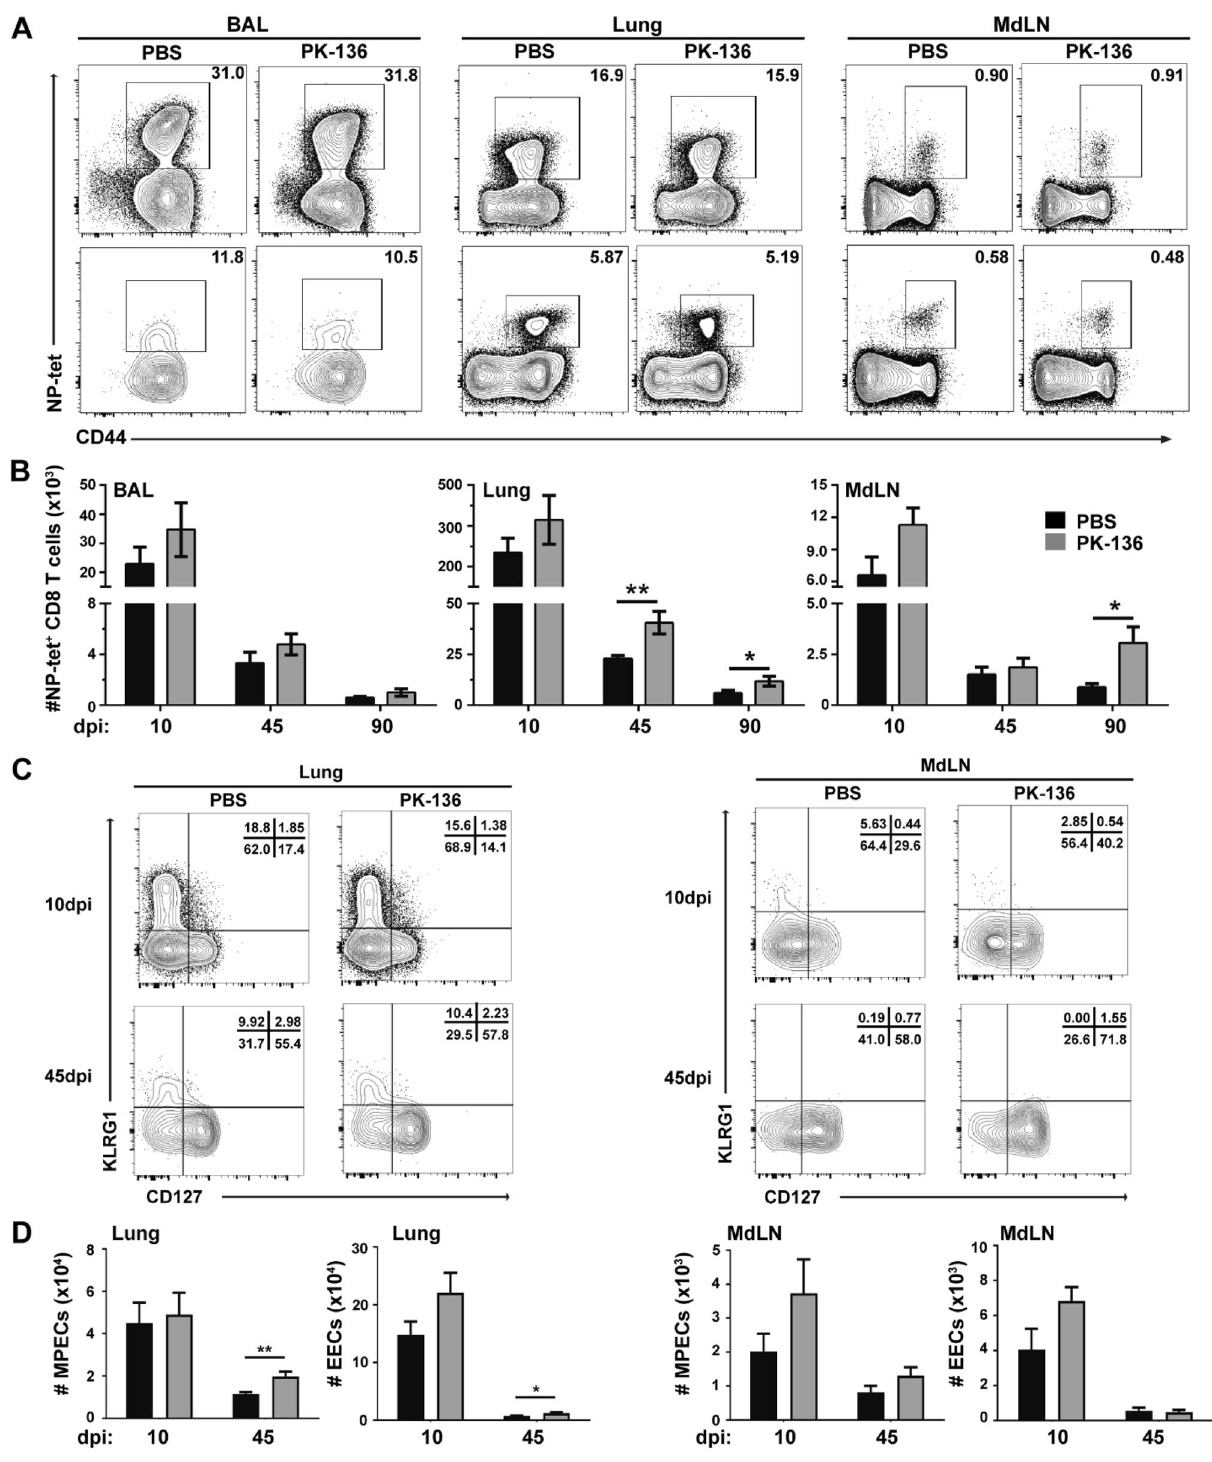
Figure 1. Anti-influenza CD8 + T cells are numerically increased following NK cell depletion. C57BL/6 mice were infected with 10 3 PFU x31 and administered PBS or the NK depleting antibody at −1, 1, and 3 dpi. ( A ) Representative flow of activated (CD44 hi ), NP-tet + cells recovered from the BAL, lung, and MdLN of animals after gating on single cells, lymphocytes and CD8 + cells. ( B ) The kinetics of the CD8 + T cell response based on the total number ± SEM of activated (CD44 hi ), NP-tet + CD8 + T cells recovered from the BAL, lung, and MdLN of animals that were treated with PBS (black) or depleting antibody (grey) is depicted. ( C ) Representative flow of CD127 and KLRG1 expression by NP-tet + CD44 + CD8 + T cells from the lung and MdLN of NK sufficient or depleted mice 10 and 45dpi. ( D ) The total number of CD127 + KLRG1 - (MPECs) and CD127 - KLRG1 - (EECs) cells in the lung and MdLN of animals treated with PBS (black) or PK136 (gray), previously gated on CD8 + CD44 hi NP-tet + cells. Graphs represent pooled data from 3 or more independent experiments using n ≥ 3 mice/group/time point (total of 9 mice per group/time point). *p < 0.05; **p < 0.01; unpaired Student’s t-test with Holm–Sidak multiple comparisons